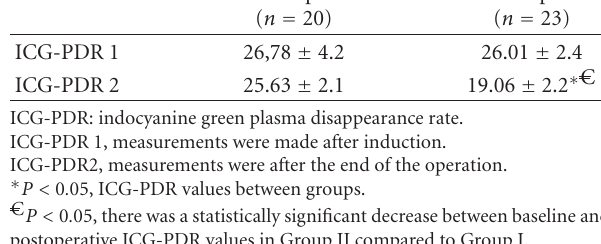
Table 3: ICG-PDR values. Table 4: Serum AST (U/L), ALT (U/L), and total bilirubin (mg/dL)